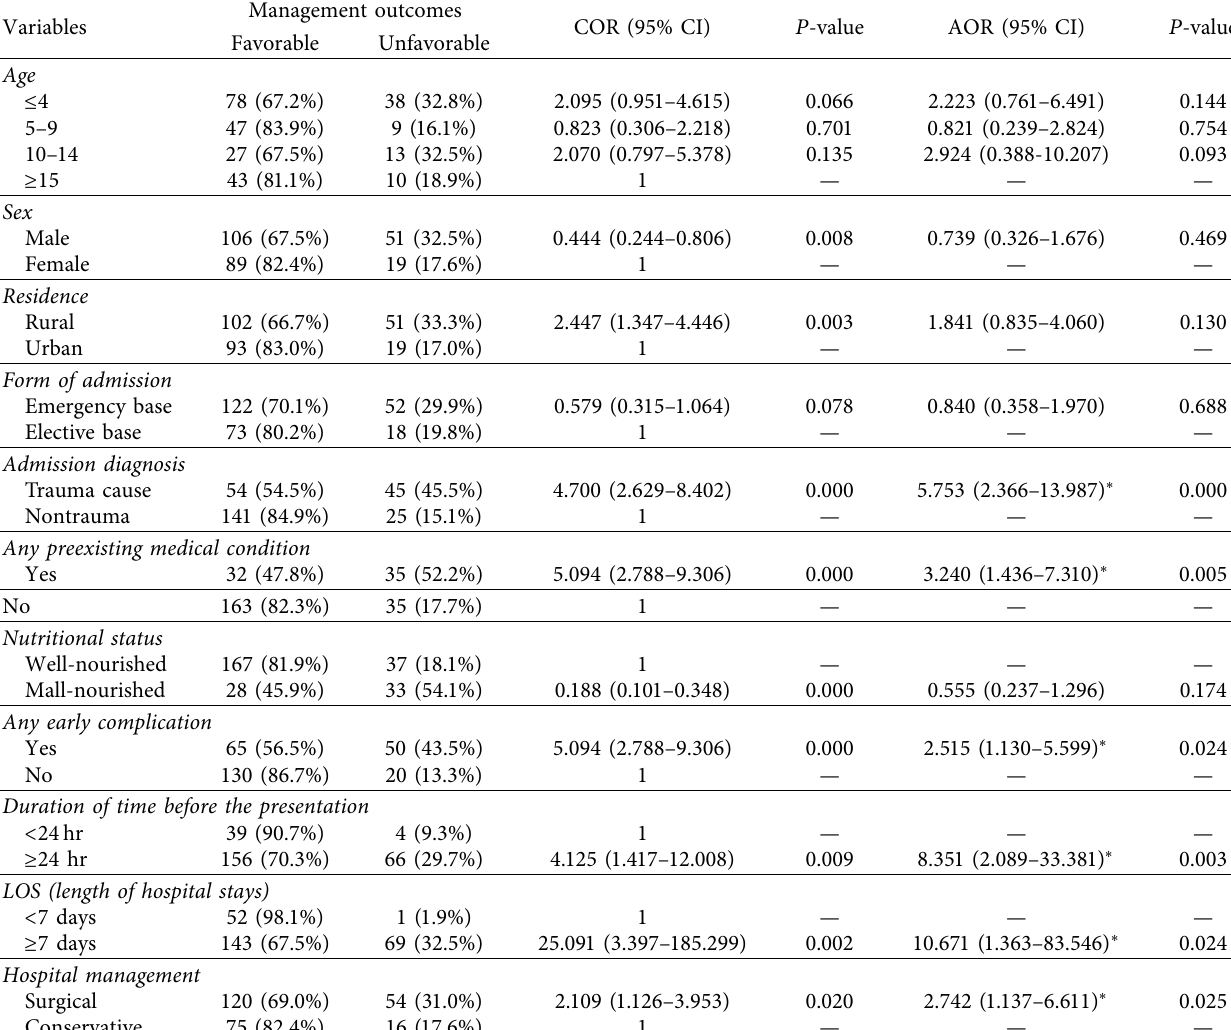
Table 3: Bivariable and multivariable logistic regression showing factors associated with the management outcome of pediatric